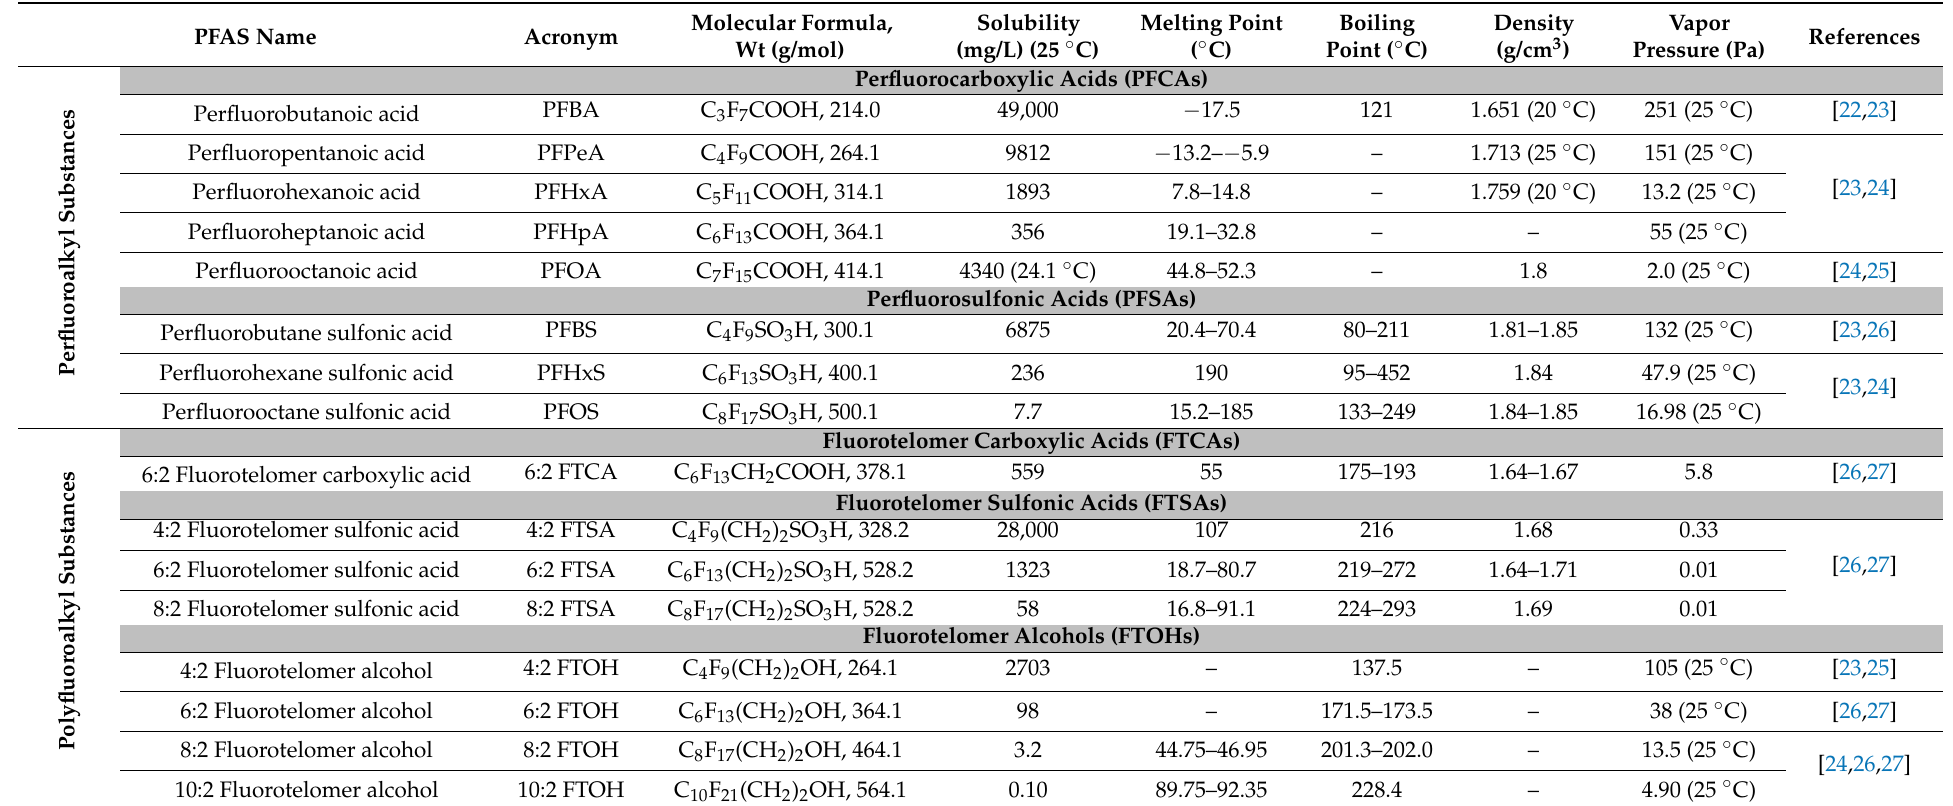
Table 1. Chemical properties of some selected